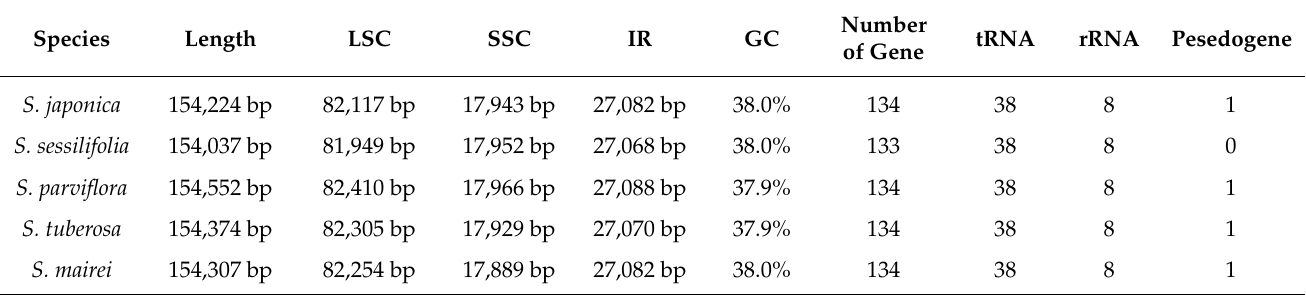
Table 1. Comparative analysis of the complete chloroplast genome of genus Stemona